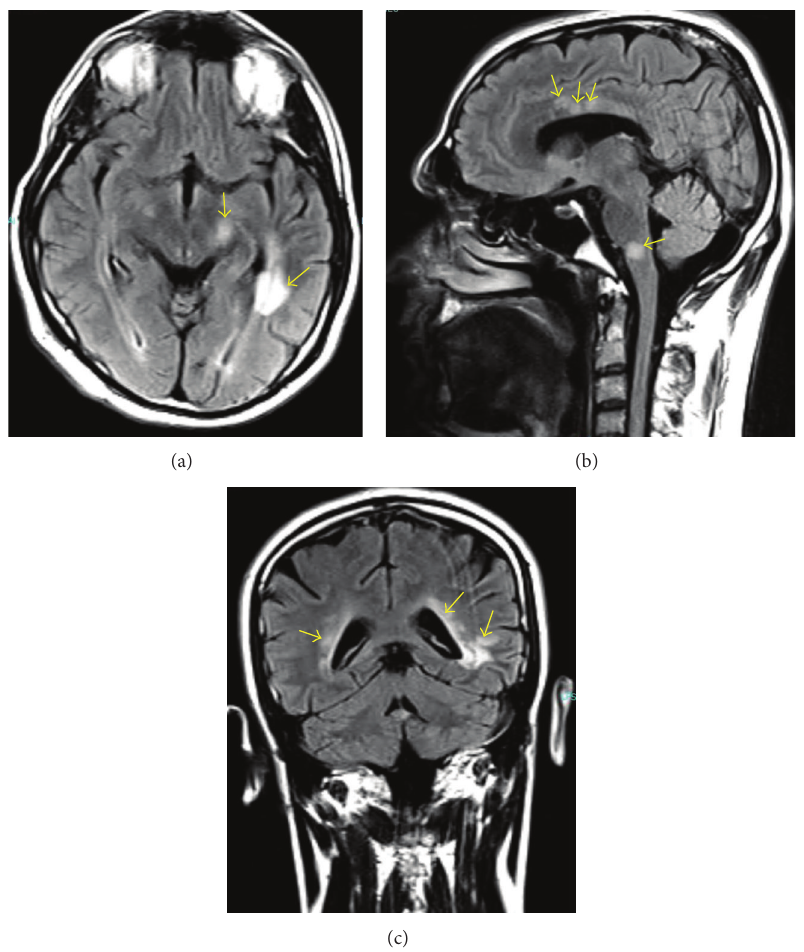
Figure 1: Cranial MRI showing (a) axial, (b) sagittal, and (c) coronal T2-weighted FLAIR views of the demyelinating lesions in the bilateral periventricular, juxtacortical, and infratentorial regions